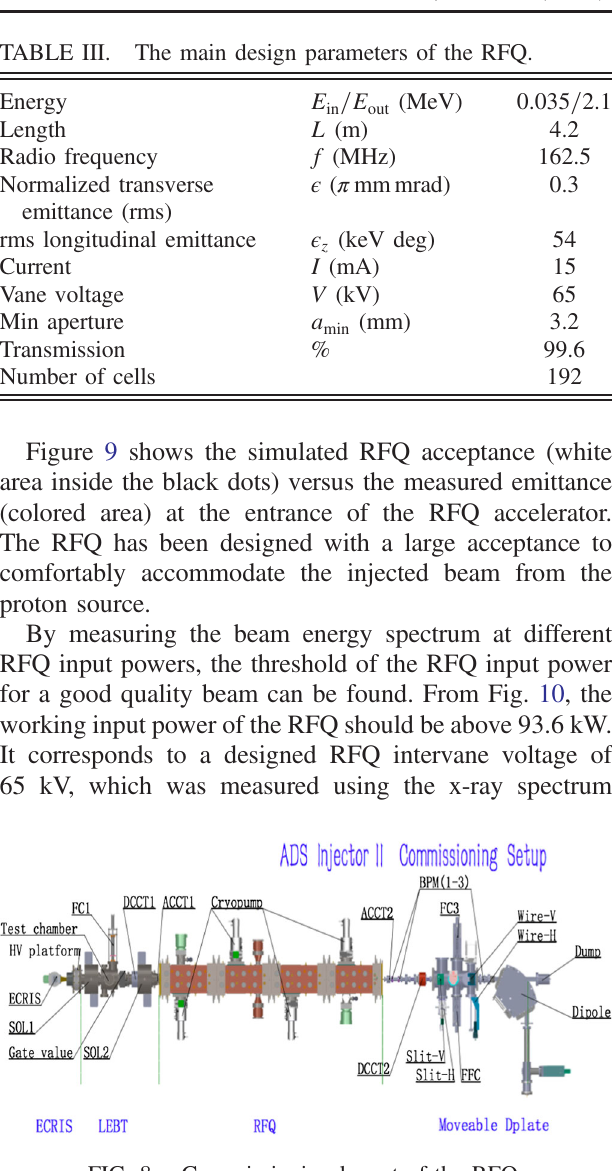
FIG. 8. Commissioning layout of the